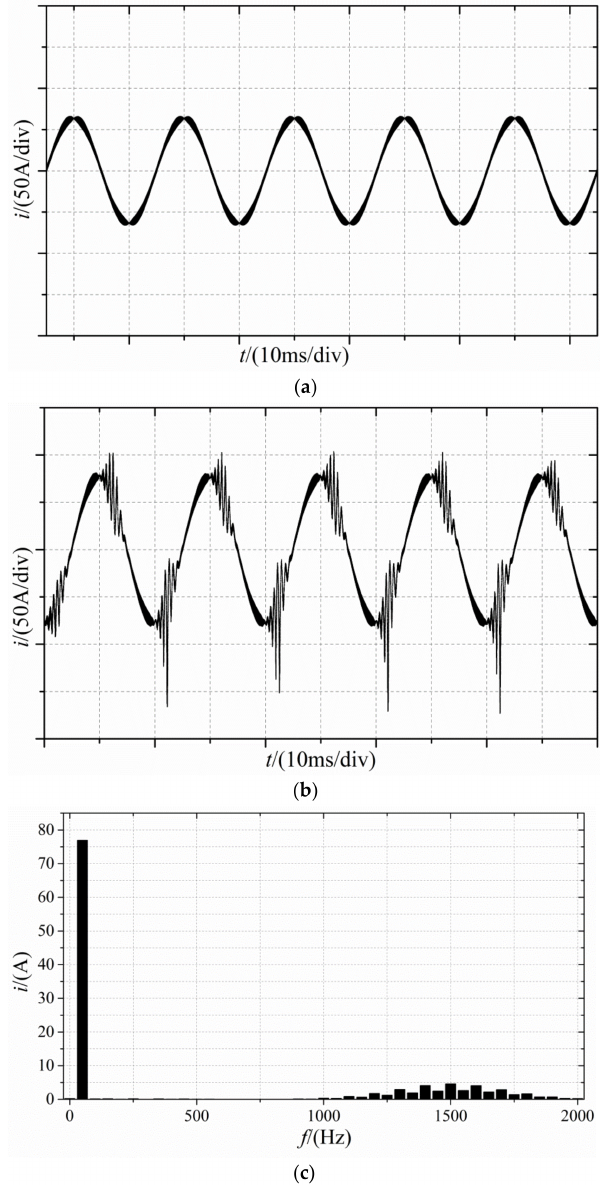
Figure 7. Simulation results with different magnitudes of output current reference before the loop gain compensation unit is introduced: ( a ) magnitude of output current reference is 60 A; ( b ) magnitude of output current reference is 70 A; ( c ) spectra of the output current when its reference magnitude is 70